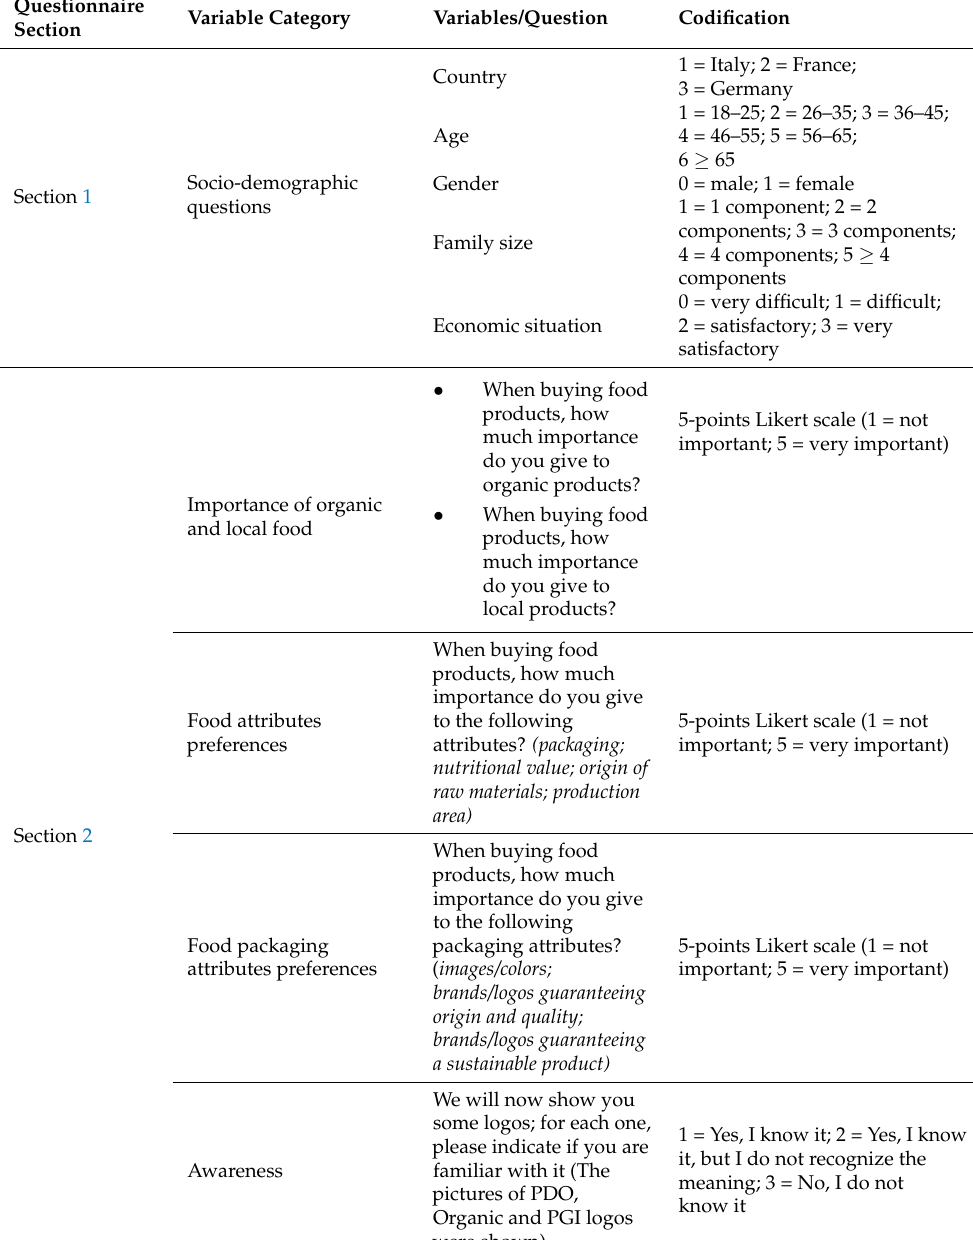
Table 1. Questionnaire framework. The variable codification employed for the analysis is also